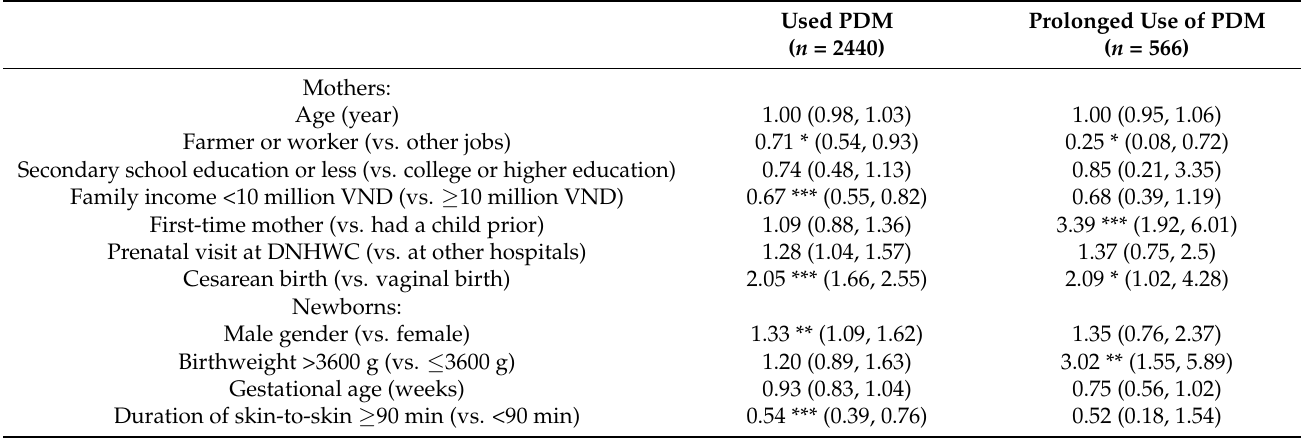
Table 3. Factors (adjusted OR; 95% CI) associated with the use and prolonged use of pasteurized donor milk among healthy newborns in postnatal